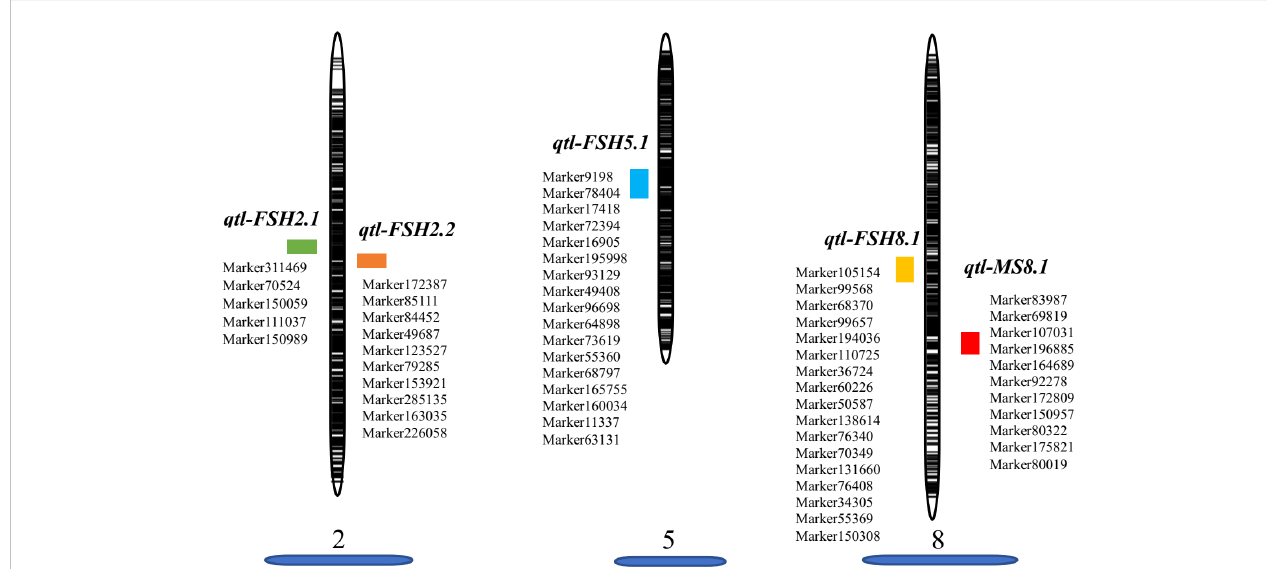
FIGURE 4 Graphic view of the distribution of markers associated with related traits on onion LGs 2, 5, 8.